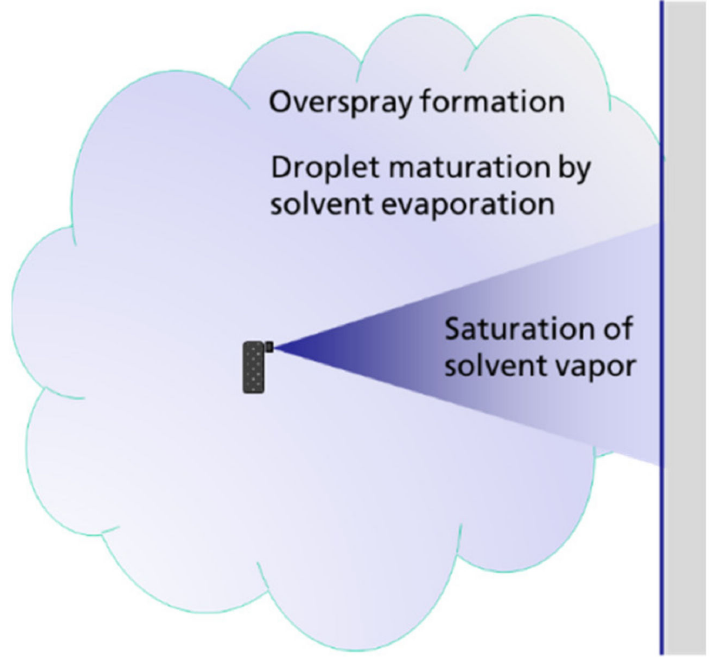
Figure 1. Illustration of the aerosol formation during spraying activities. Non-deposited droplets constitute the overspray. Overspray droplets mature due to solvent evaporation and shrink to a final size depending on the concentration of the non-volatile component in the formulation. Inside the spray cone, solvent vapour may reach saturation due to the large surface area of the dispersed